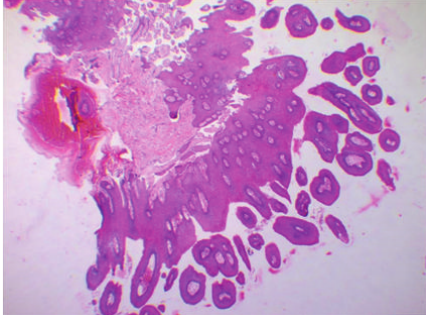
Figure 7: Photomicrograph of the lesion showing multiple papillary epithelial projections with fibrovascular connective tissue cores (H&E, 4x).